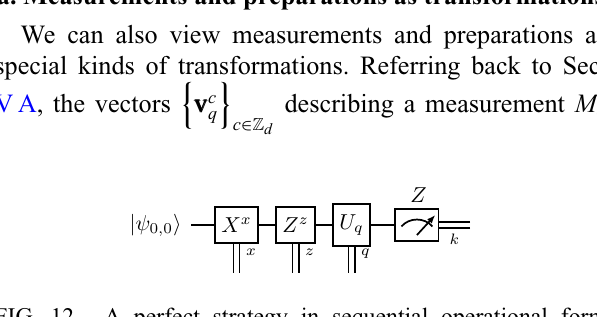
FIG. 12. A perfect strategy in sequential operational form for the dimension d Torpedo Game for odd power-of-prime d . The classically controlled gates are appropriately defined Pauli operators or Clifford gates as in Eq.